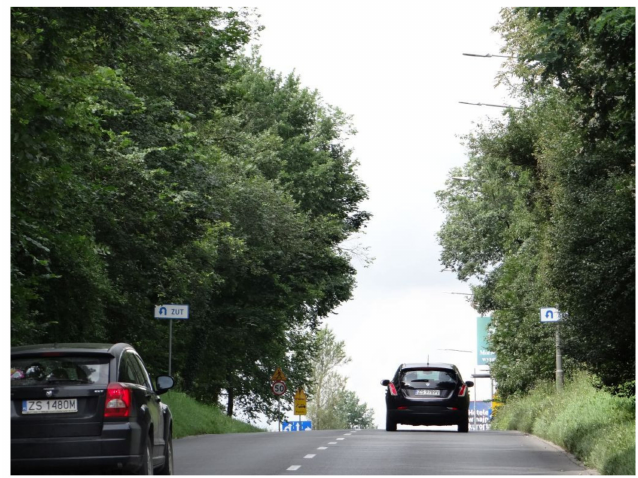
Figure 4. Approach to the study area on the westbound carriageway leading from the city centre, running in a cutting with ca. 3–4% longitudinal